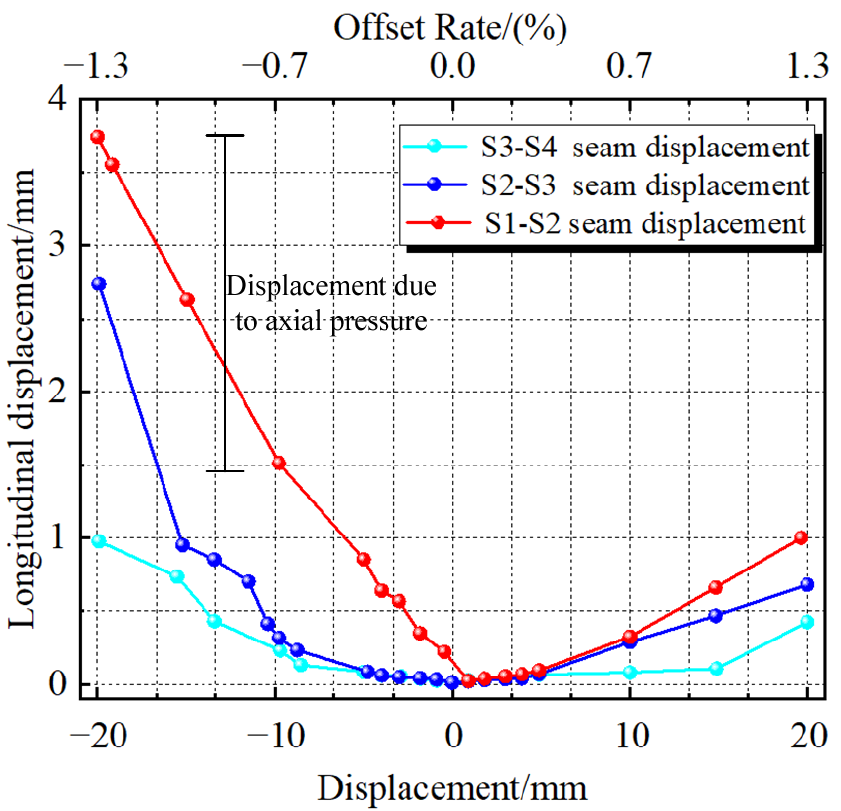
Figure 18. Longitudinal displacement of arched steel plates of each joint arch energy ‐ consuming device.